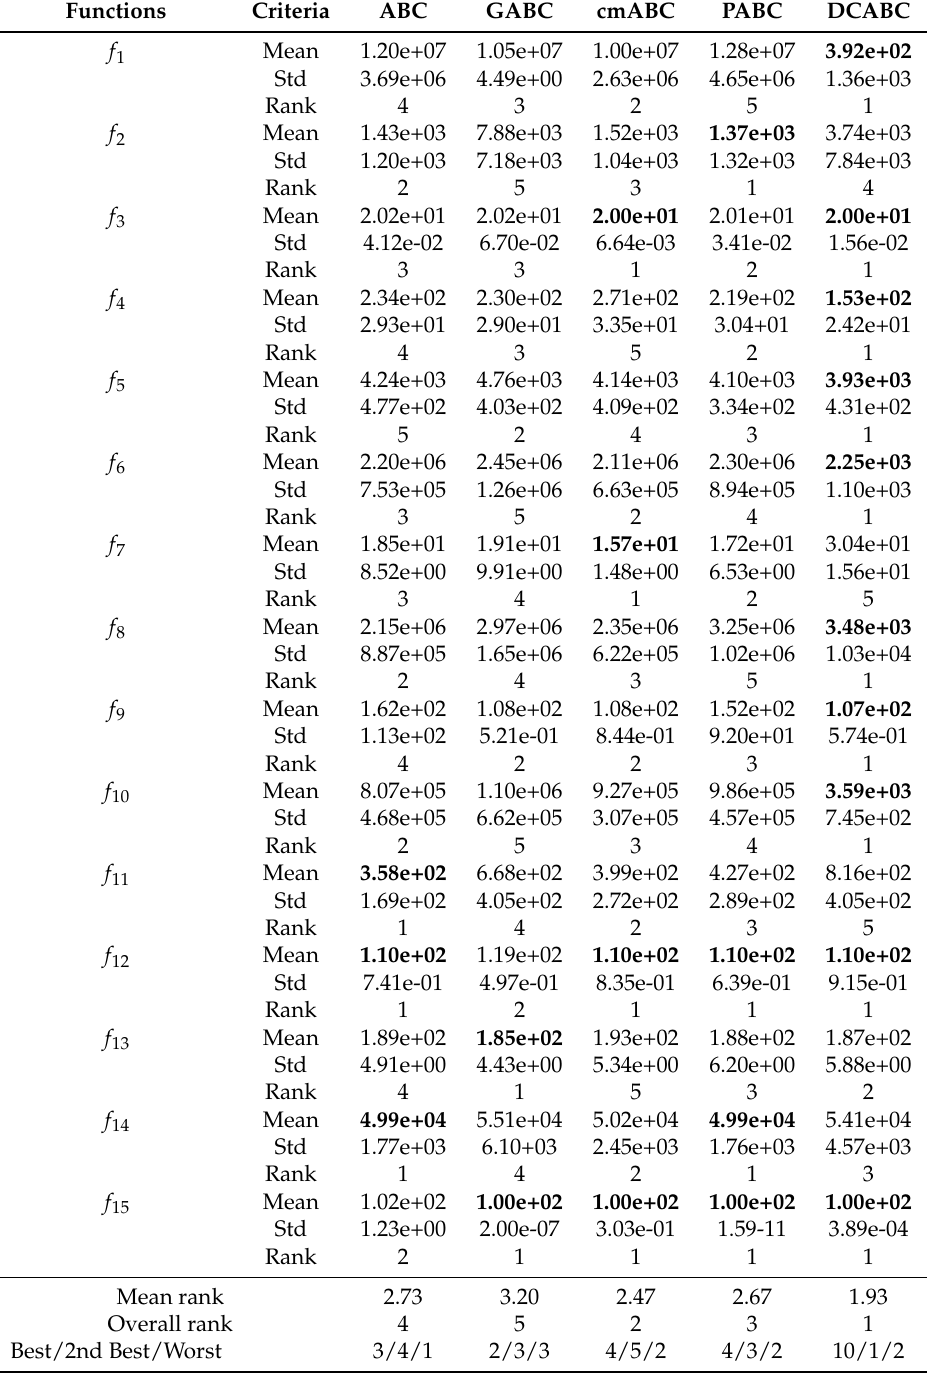
Table 4. Experimental Results about ABC and other ABC variants